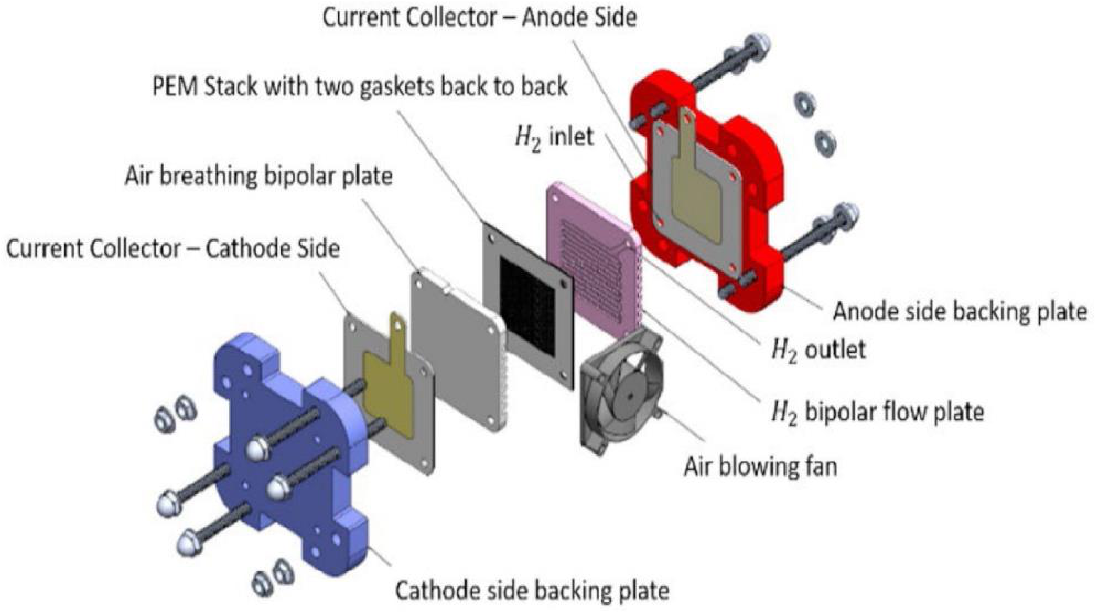
Figure 2. Components in proton exchange membrane fuel cell [29] (license no. 5172441445841).